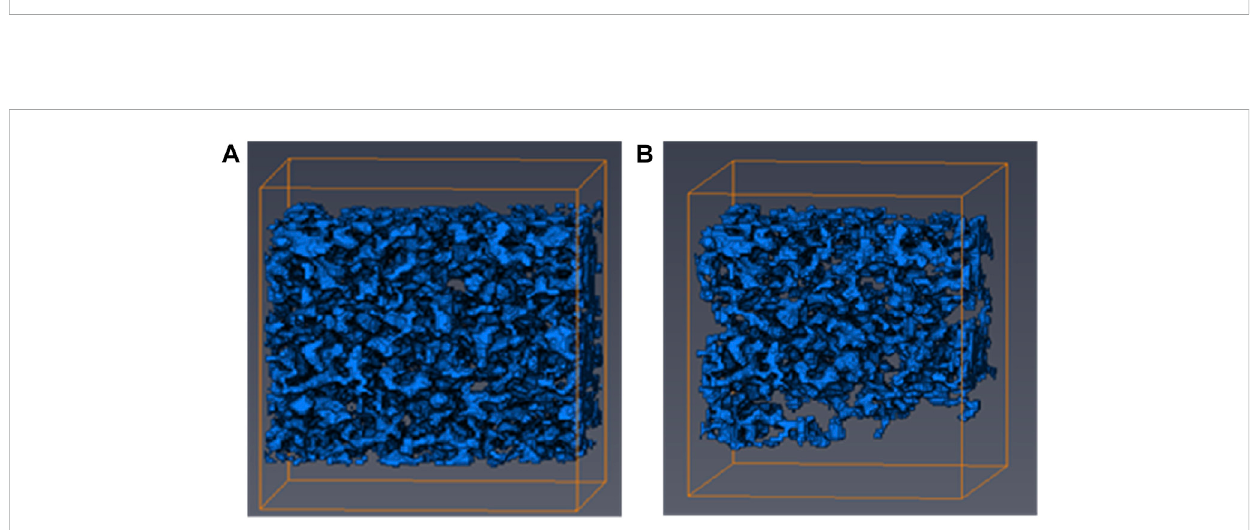
FIGURE 3 3D digital cores of deep shale (A) with isolated pores and (B) without isolated pores.